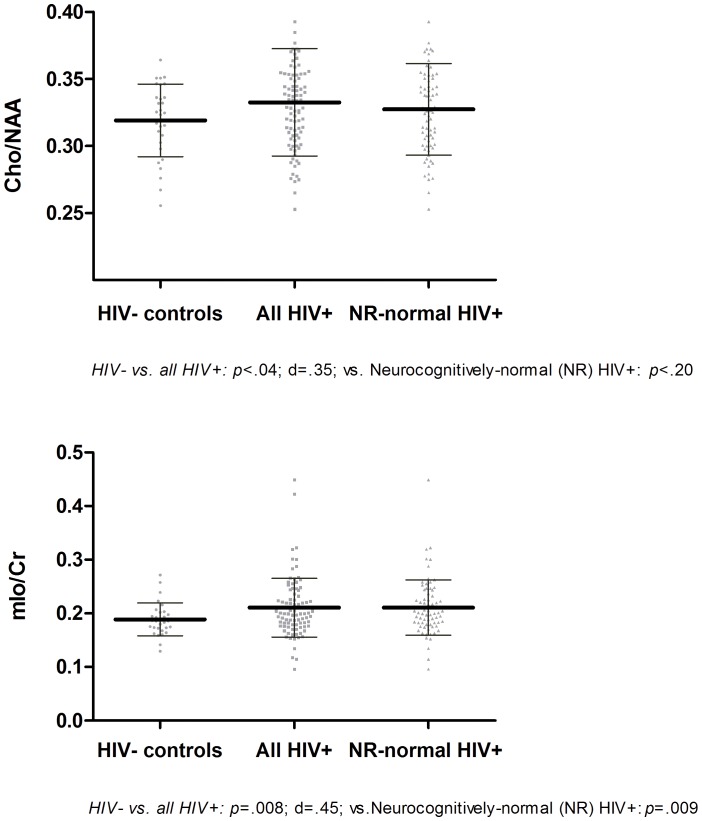
Significant moieties’ difference between theHIV− and HIV+ groups in the Posterior Cingulate Cortex.